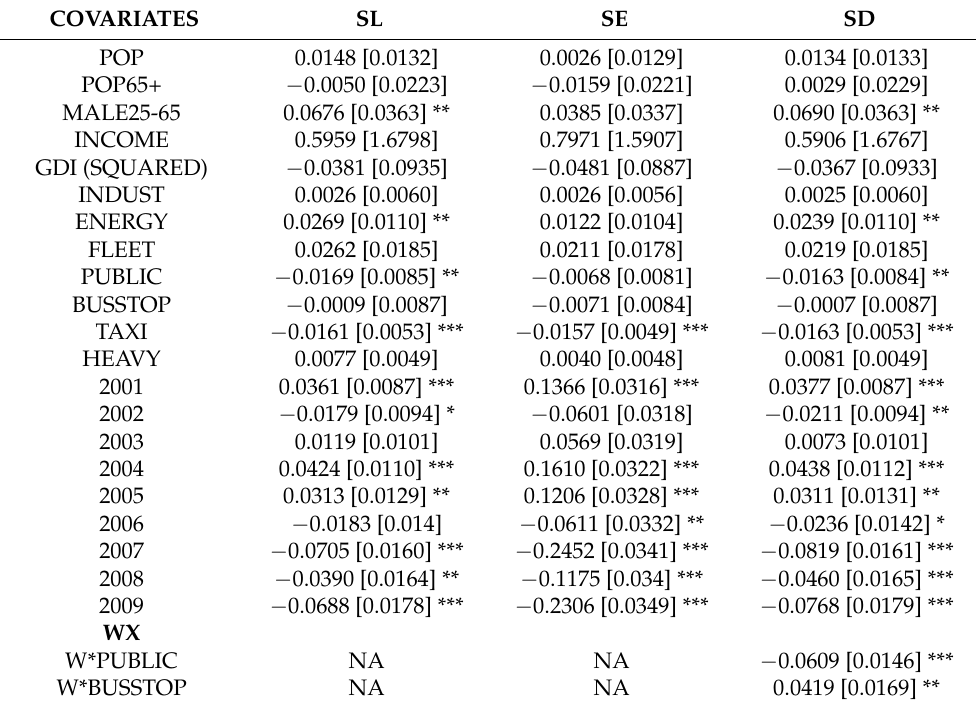
Table A3. Estimates of coefficients for Spatial-PD-STIRPAT models (Random Effects).